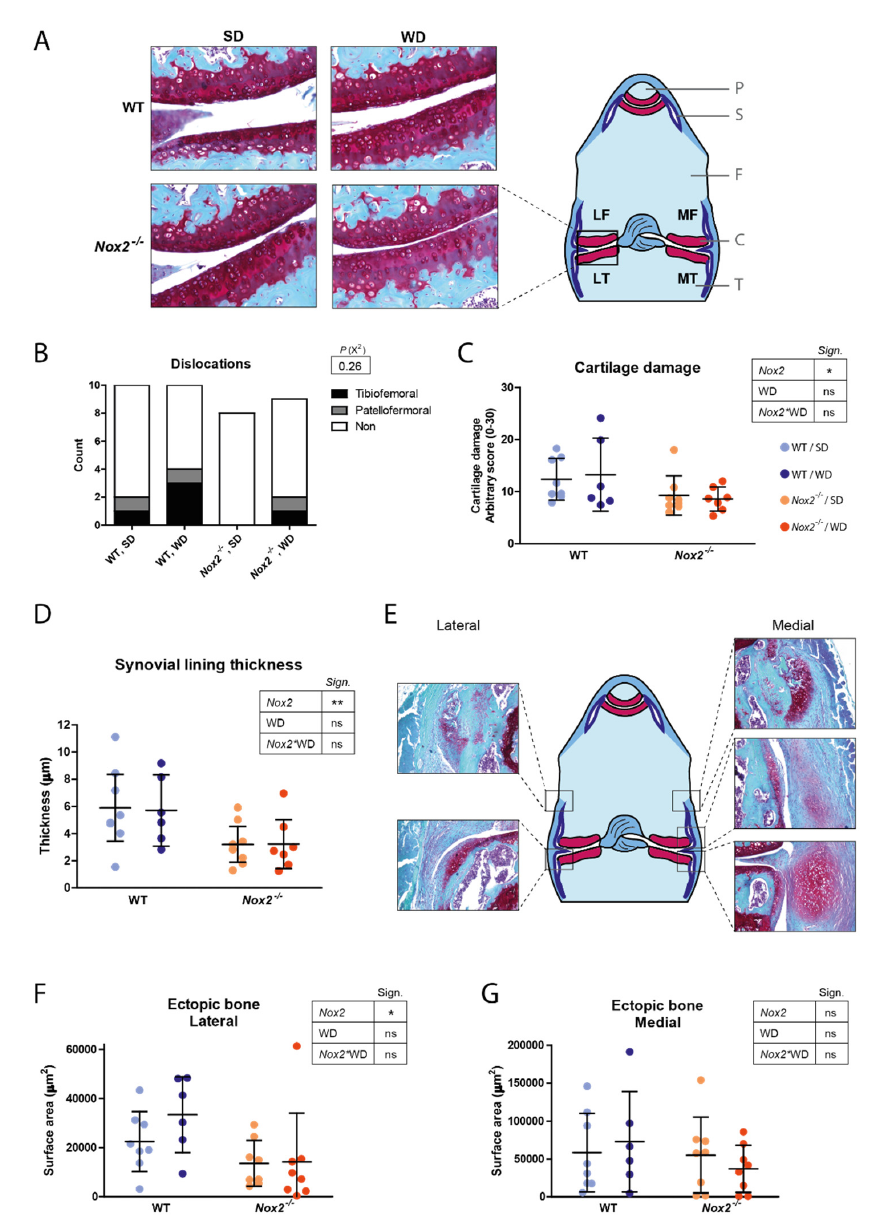
Figure 5. Decreased cartilage damage, synovial lining thickness and ectopic bone formation in Nox2 − / − mice at day 21 of CiOA. ( A , E ) Illustrations each show a schematic overview of a frontal section of a SafO stained knee joint. P, patella; S, synovium; F, femur; C, cartilage; T, tibia. ( A ) Sites where cartilage was scored is presented as LF (lateral femur), MF (medial femur), LT (lateral tibia) and LF (lateral femur). Pictures are representative of the mean across groups (200 × magnification). Dislocations were excluded from further analysis ( B ). ( C ) Cartilage damage in the tibial-femoral joint was scored using a modified OARSI score, in which the grade (severity of erosion) is multiplied by the stage (affected area), resulting in a score of 0–30 (0 = no damage, 30 = maximal damage). Five sections were scored per knee joint. ( D ) Synovial lining thickness at day 21 of CiOA was scored on H&E stained histological sections by measuring the thickness in µ m. Three sections of different standardized depths were scored per knee joint. ( E – G ) Ectopic bone was scored at five different sites in the joint ( F ). Ectopic bone masses were manually circled by an investigator blinded for the experimental condition, after which the surface areas were calculated. The mean cross-sectional surface area in three sections per knee joint was determined, and the measurements on the lateral ( F ) and medial ( G ) side of the joint were averaged separately. Pictures are representative of the mean across groups (50 × magnification). Data are presented as mean and 95% CI’s. p -value summary resulting from two-way ANOVA shown in tables: *, p < 0.05; **, p < 0.01; ns, p >